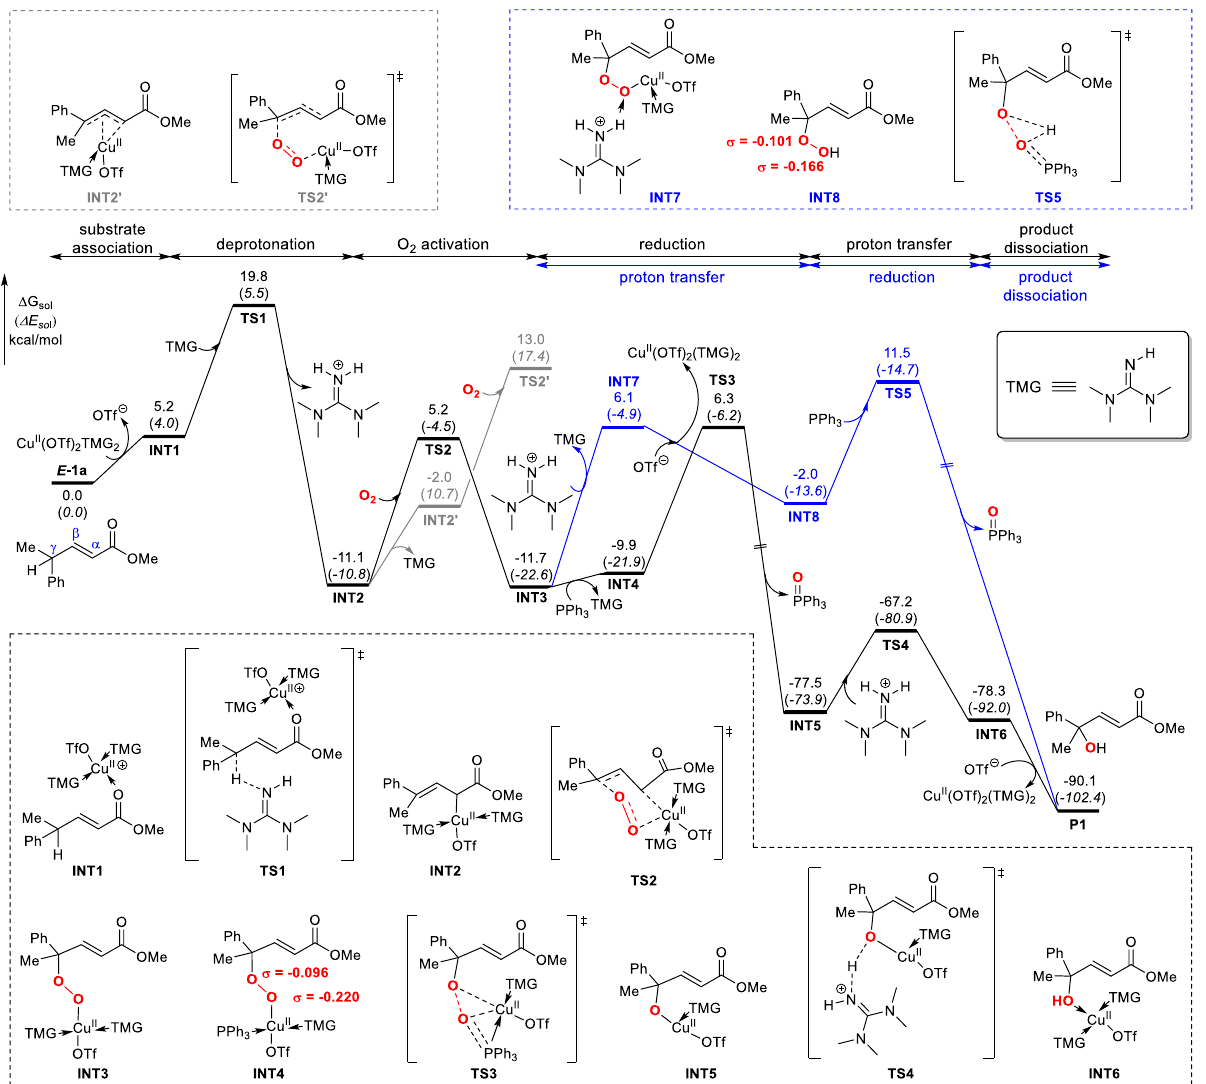
Figure 1. Computed energy profile of copper-catalyzed vinylogous aerobic oxidation of α , β -unsaturated ester. Relative free energies (electronic energies) are in kcal/mol. The Hirshfeld charges of O atoms (highlighted in red) on INT4 and INT8 are